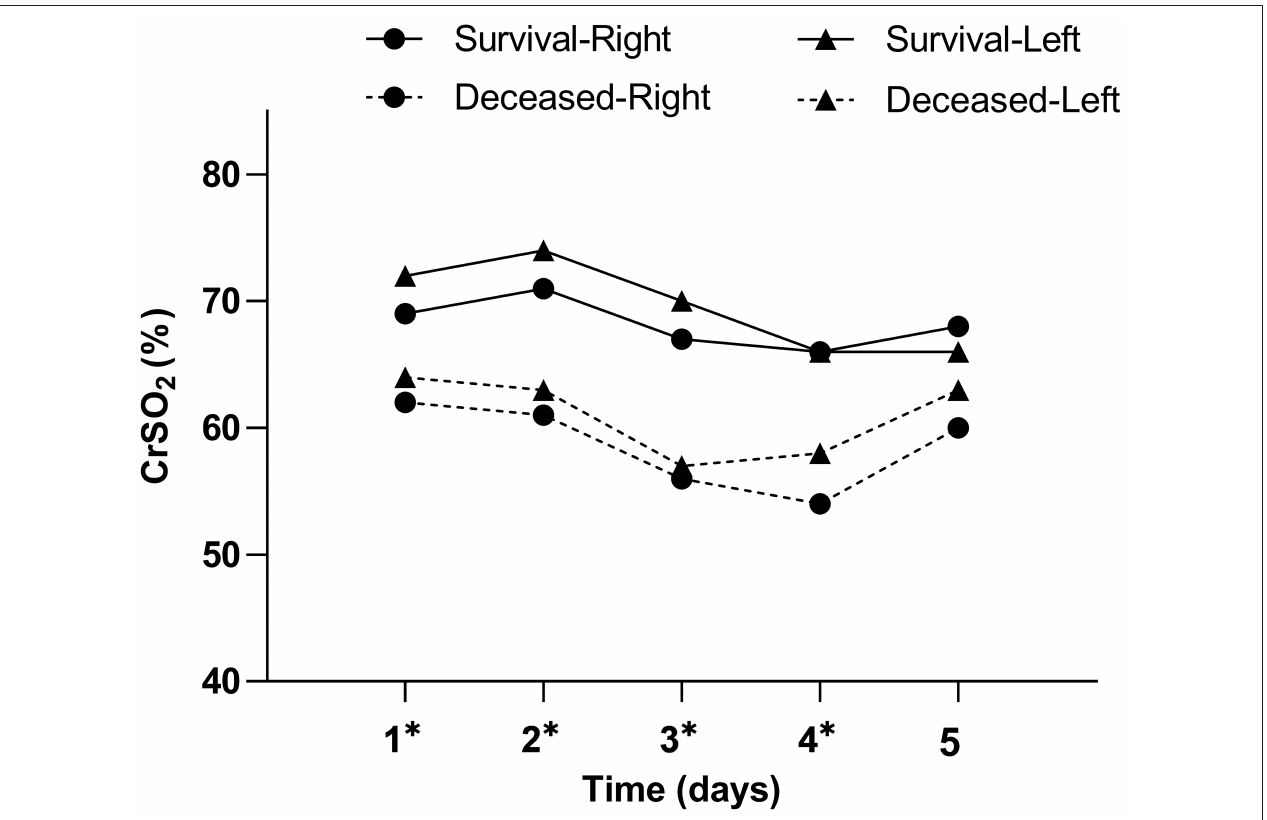
FIGURE 2 | Daily CrSO 2 for the first 5 days following ECMO initiation according to PICU mortality. Results of the generalized estimating equation (GEE) indicate significant differences between survivors and non-survivors for each of the first 4 days following ECMO initiation in both hemispheres. * p < 0.05.